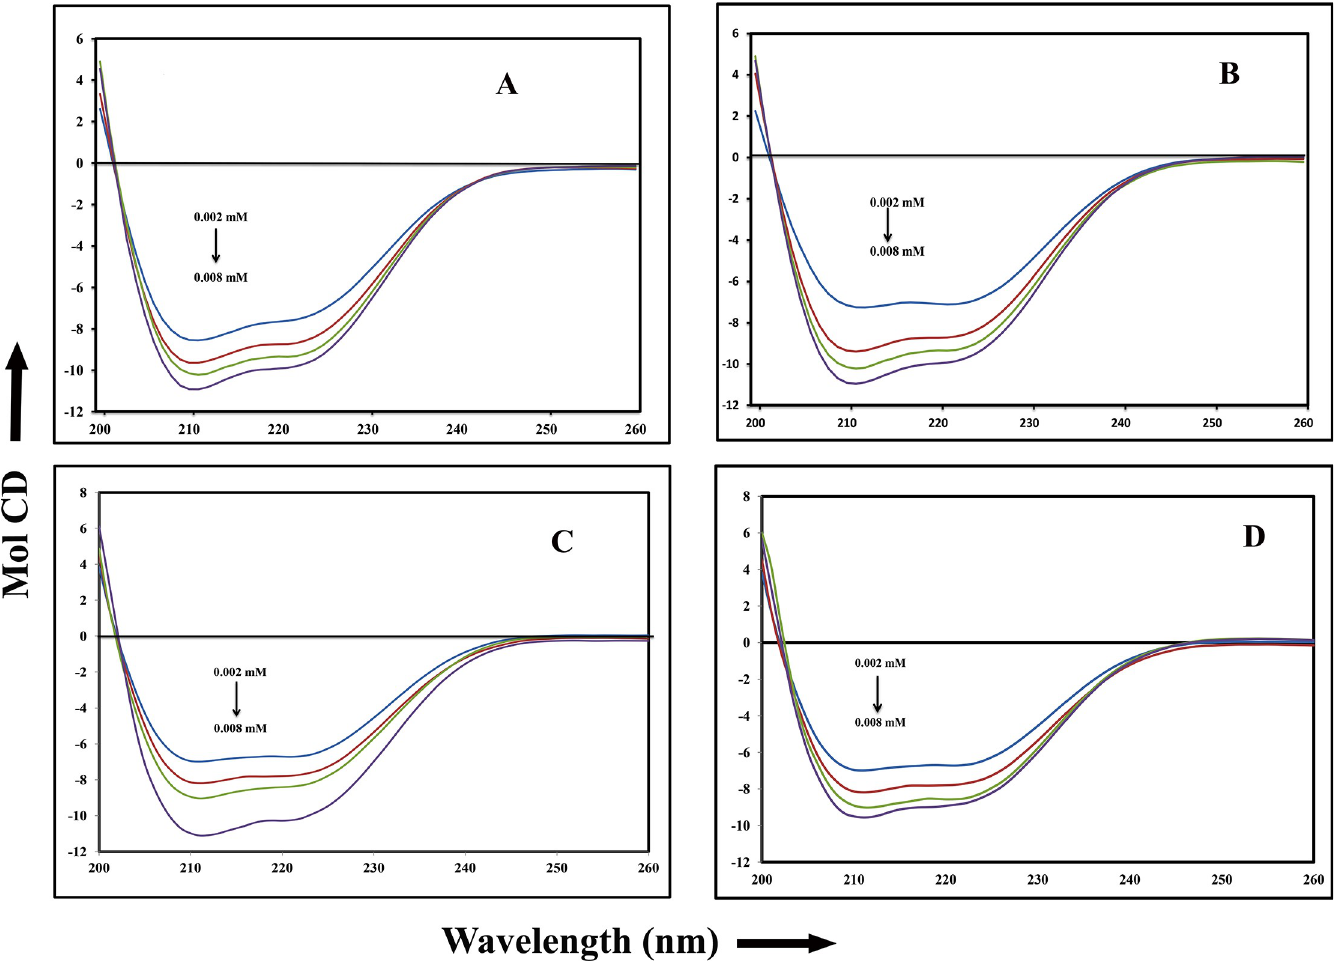
Fig 4. Circular Dichroism studies of the free HSA and HSA–drug complexes. The free HSA and HSA–drug complexes in aqueous solution with a protein concentration fixed at 1 μ M and with increasing drug concentrations at 2,4, and 6 μ M. (A) withanolide A (B) withanolide B (C) withanoside IV and (D) withanoside V.